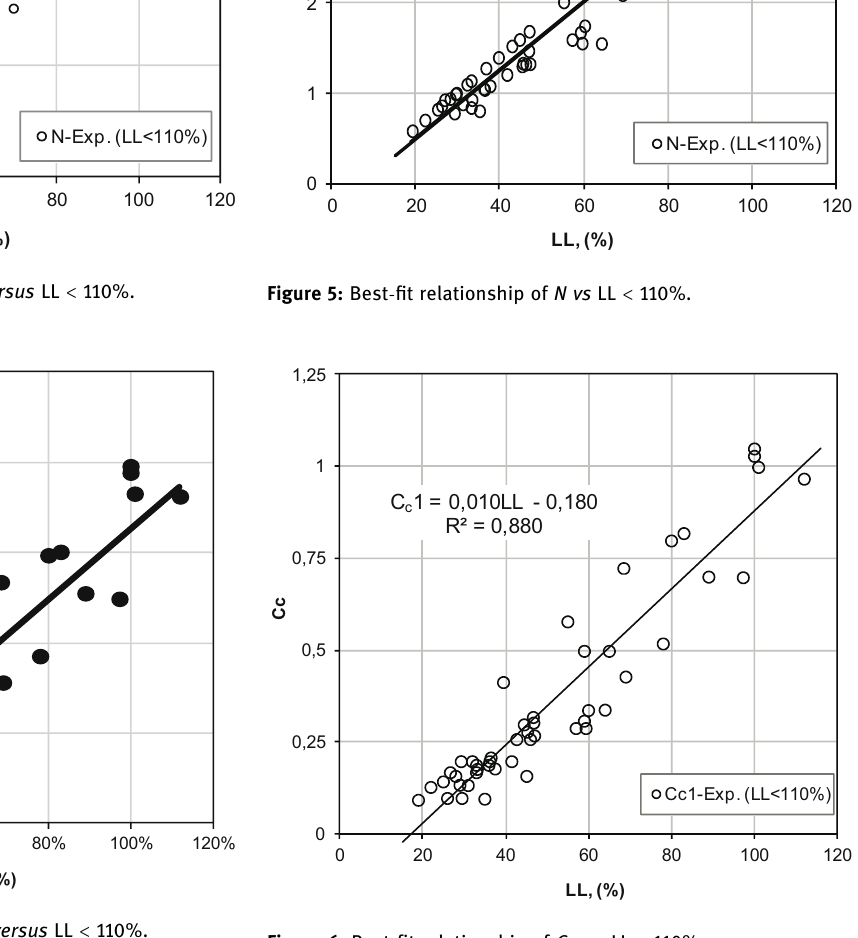
Figure 6: Best - fi t relationship of C c1 vs LL <